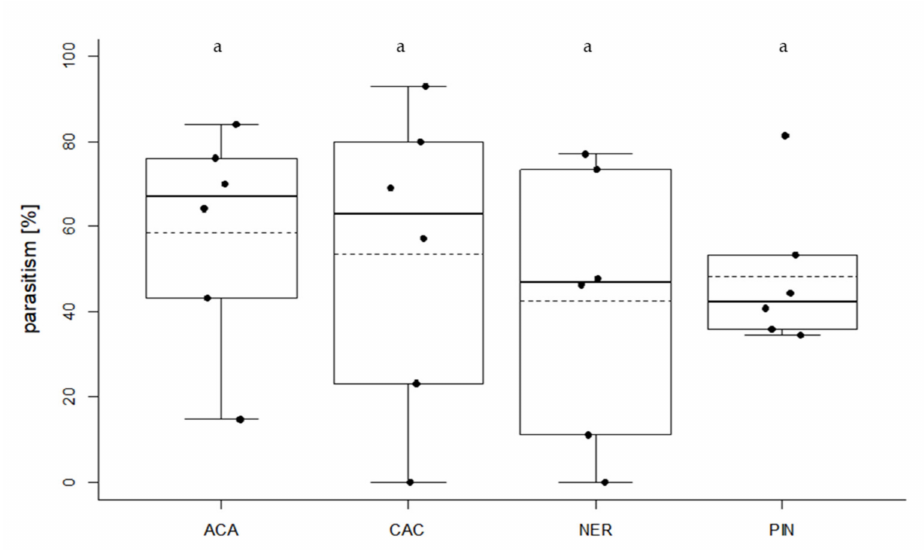
Figure 7. Host searching capacity of four Trichogramma strains on potted tomato plants (with 30 T. absoluta eggs / plant). Percentage of parasitized T. absoluta eggs at a parasitoid:host ratio of 1:1.5 is shown (six replicates). Whiskers denote range of data. In each box, medians are shown by horizontal solid lines and means by dotted